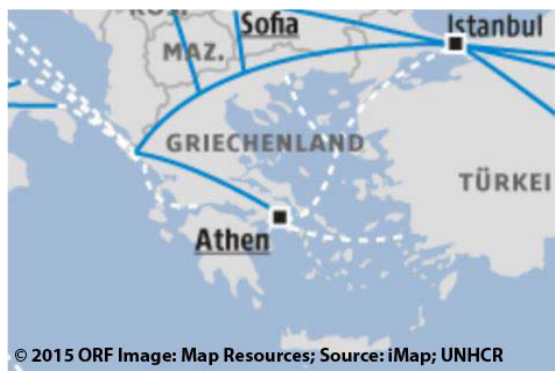
Figure 17. Primary refugee routes along the Mediterranean Sea, extract for Greece (adapted from [55]).